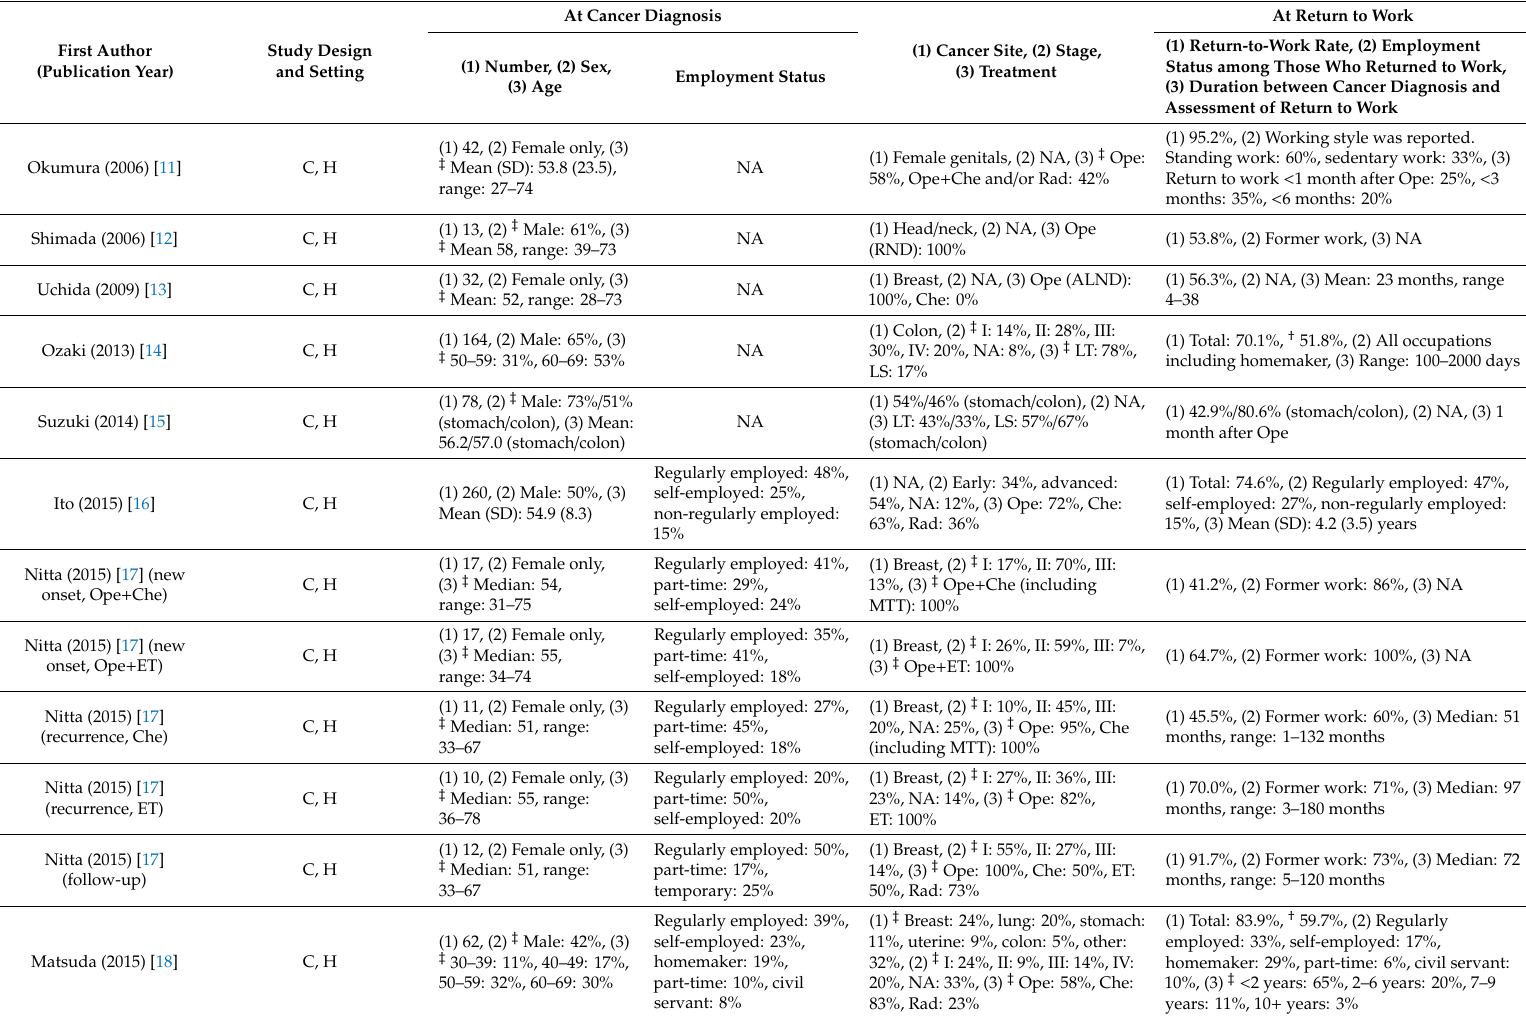
Table 1. Summary of selected